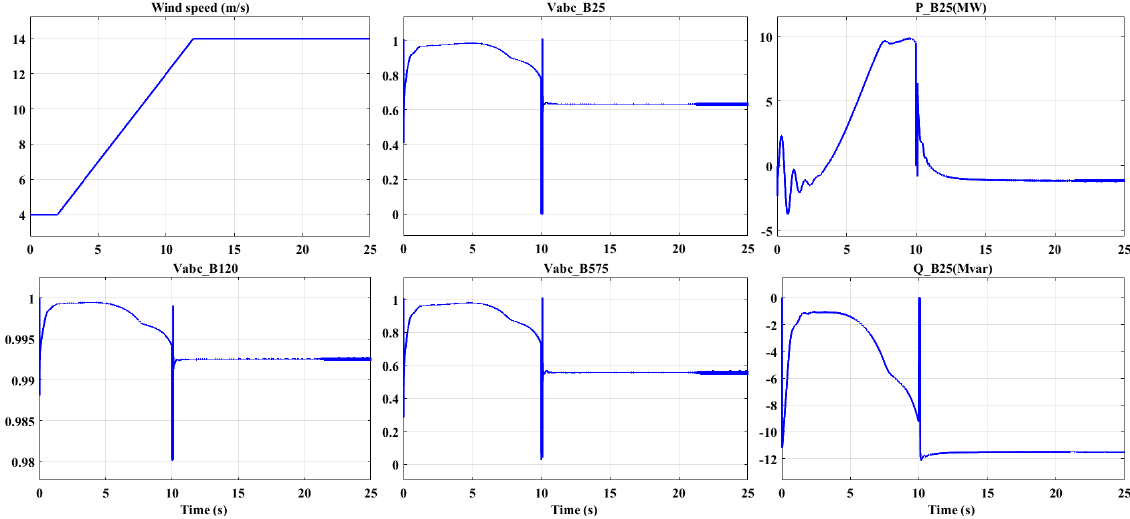
Figure 14. SCIG grid parameters at three phases short circuit fault for 0.1 s.